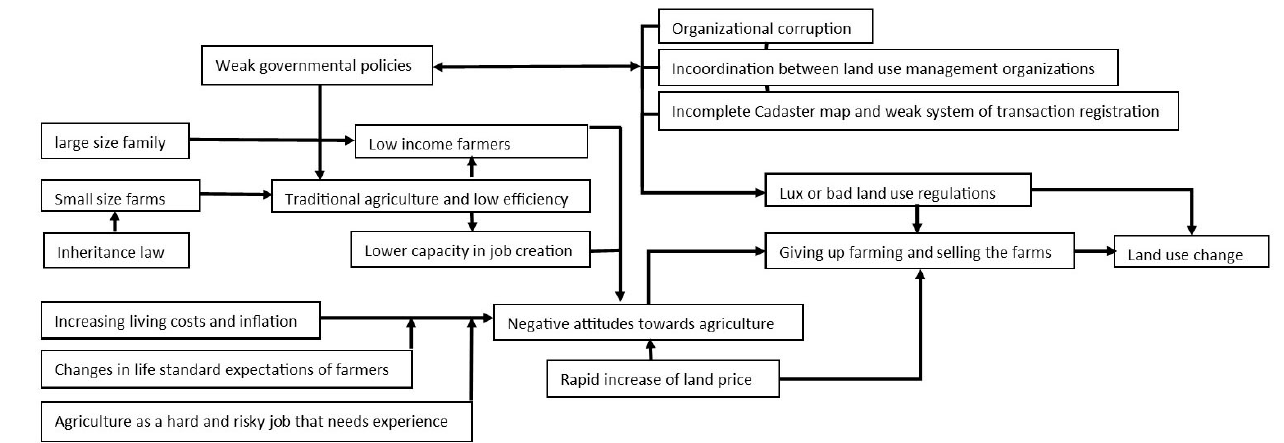
Figure 2. The relationship between factors affecting the changing land use from agricultural to tourism in the study area.